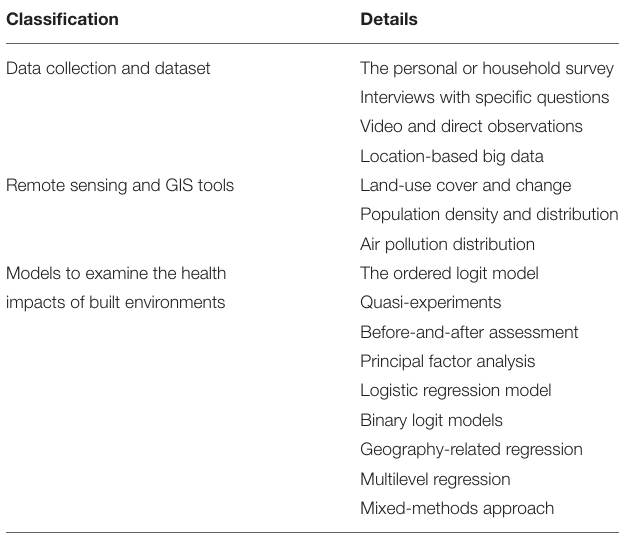
TABLE 3 | Multi-dimensional features of built environments affecting health